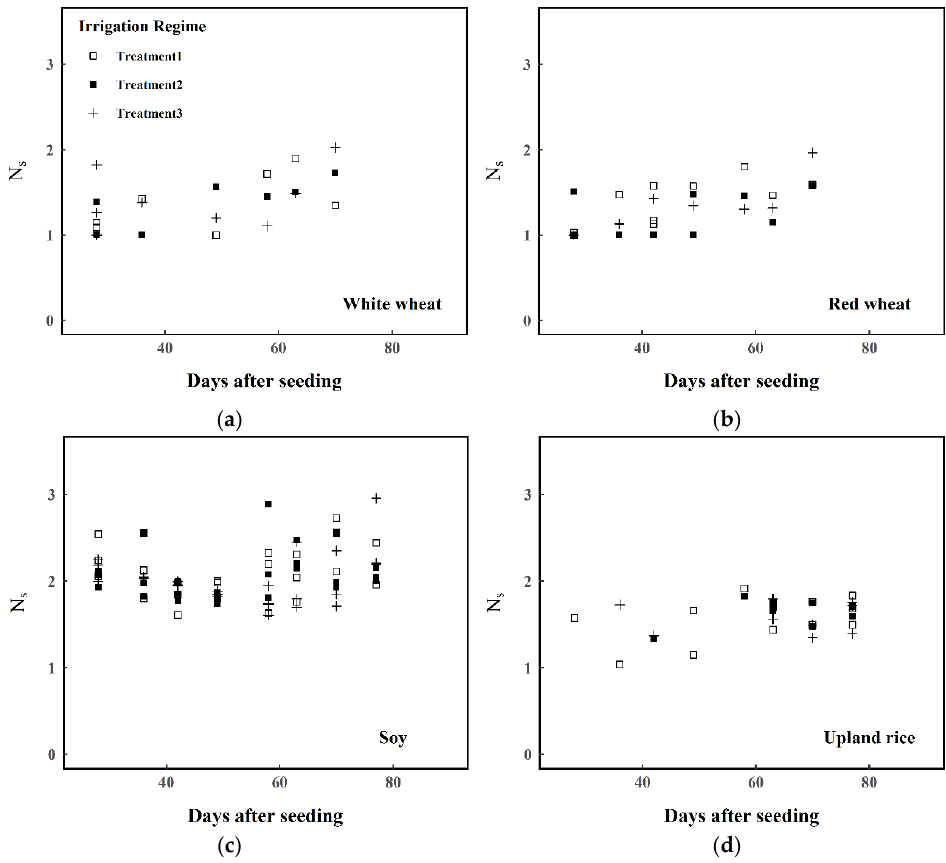
Figure 4. Estimated N s for the entire sample of the four species grown in the 2015 experiment: ( a ) white wheat; ( b ) red wheat; ( c ) soy; ( d ) upland rice. In all four plots, the symbol indicates the three different irrigation regimes: Treatments 1, 2, and 3 indicate respectively watering when the plant tray reached 85%, 75%, and 60% of the initial saturated weight.